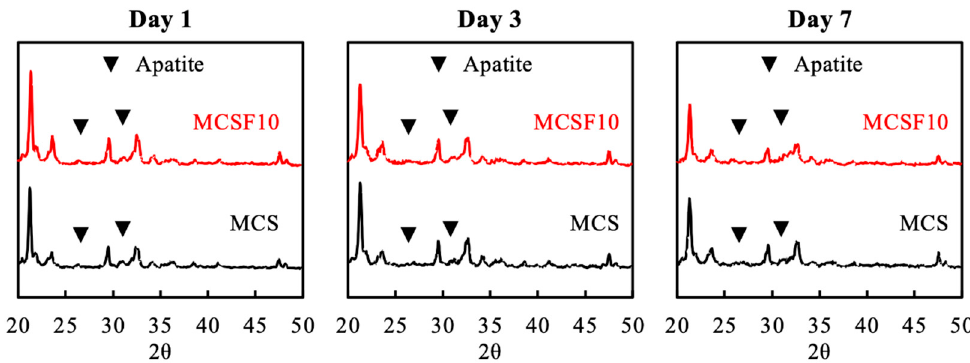
Figure 4. XRD patterns of MCS and MCSF10 scaffolds after immersion in DMEM at 37 °C for 1, 3, and 7 days.